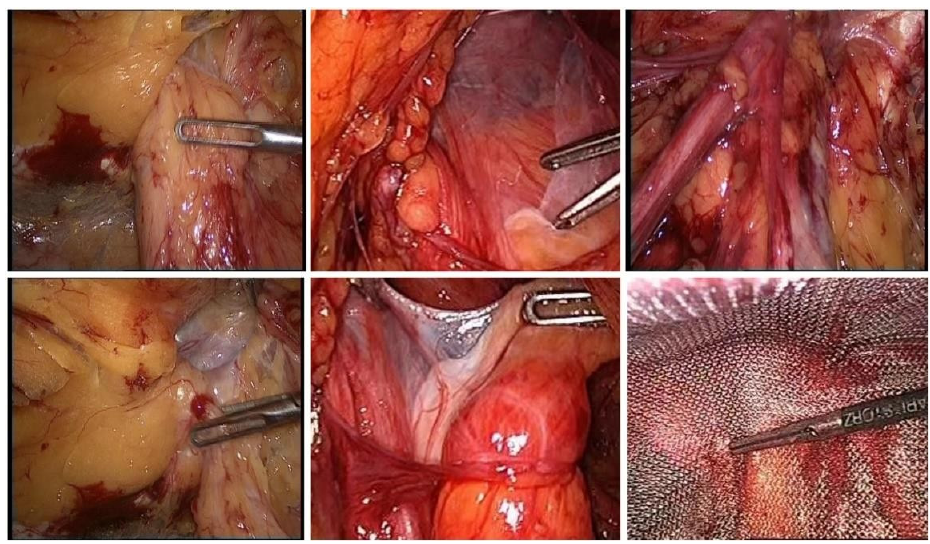
Figure 1. Intraoperative aspects during hernia surgery.